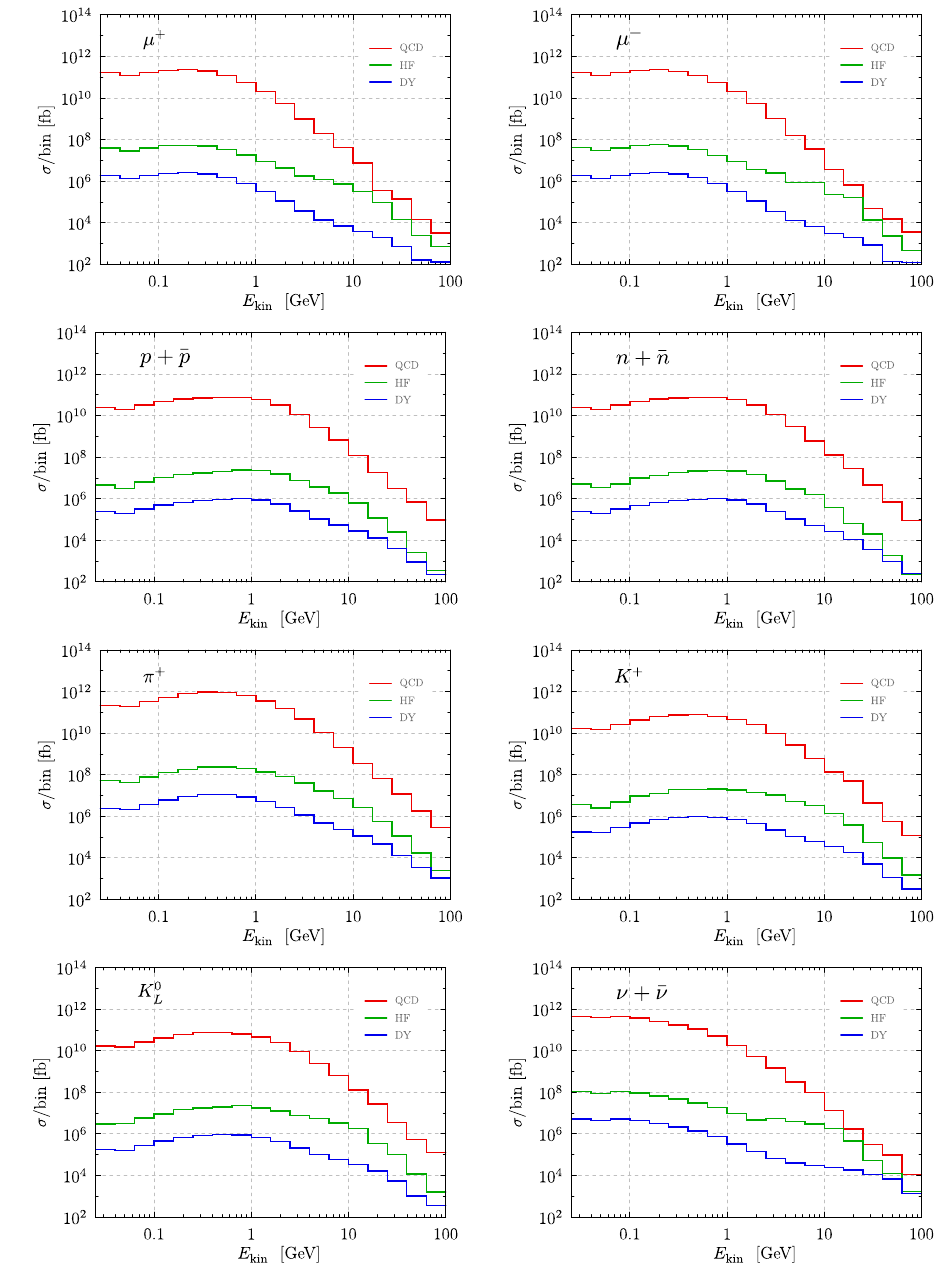
Fig. 22 IP production cross-section per kinetic energy bin, for minimum bias (QCD), Heavy Flavor (HF), and Drell–Yan (DY) production